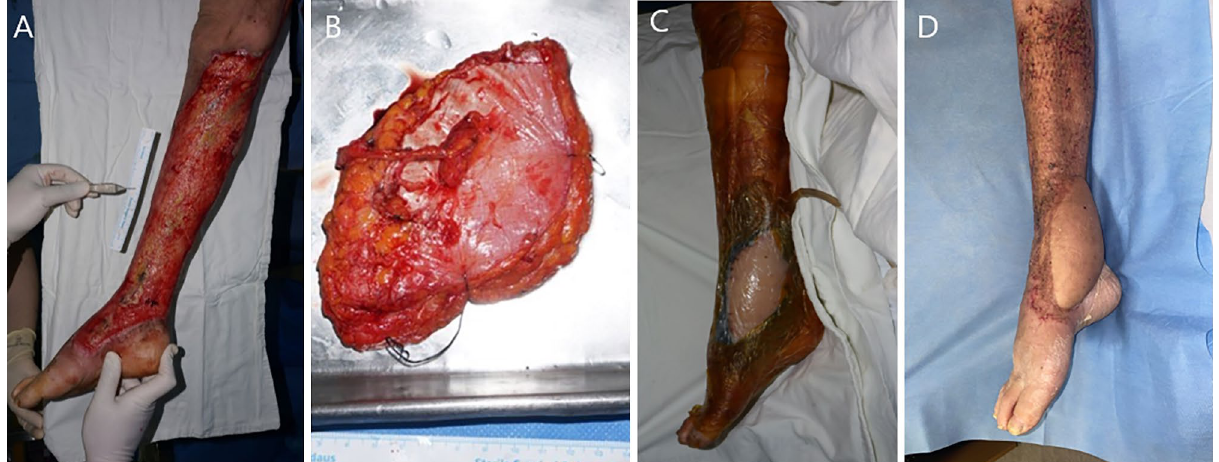
Figure 4. The second case of NPWT monitoring system in diabetic foot patient accompanied with necrotizing fasciitis. ( A ) Photographic findings of 74-year-old female patient who was diagnosed with diabetic foot accompanied with necrotizing fasciitis on right lower extremity ( B ) Harvested ALT free flap ( C ) Immediate postoperative photographic finding ( D ) Postoperative photographic finding; 7